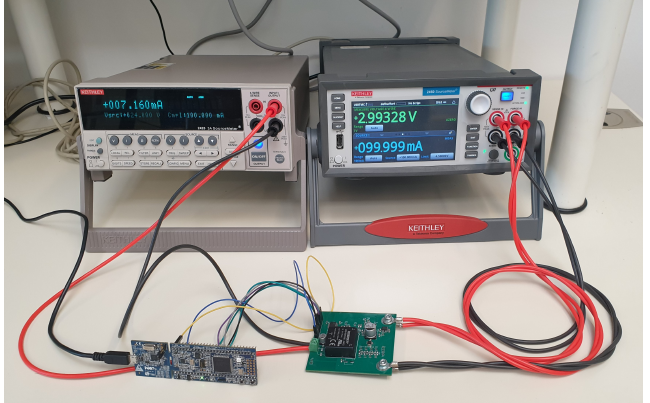
Figure 3. Experimental setup used for the cell emulator characterization.